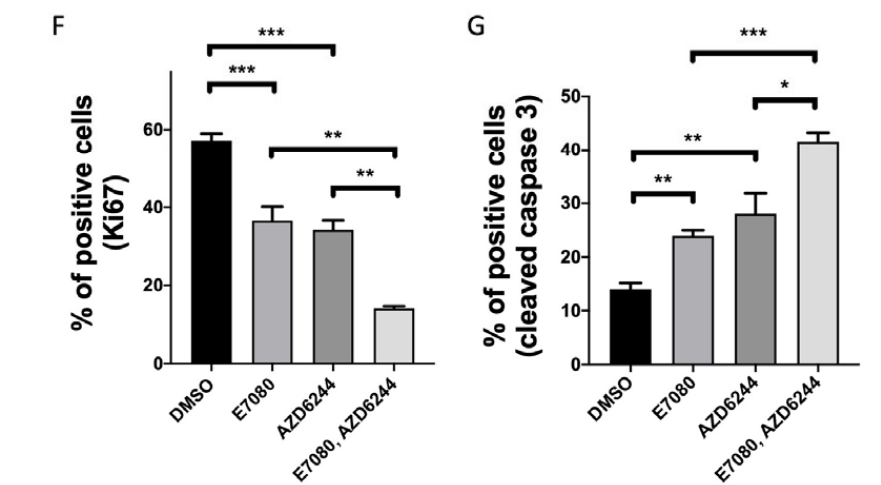
Figure 3. Antitumor effects of lenvatinib and selumetinib in 8505C-inoculated athymic BALB/c nude mice. An equal number of 8505C cells (1 × 10 6 cells) was injected into the flanks of each mouse before treatment. When tumors started to develop (average tumor size reached 100 mm 3 ), lenvatinib plus selumetinib, lenvatinib alone, selumetinib alone, or the vehicle was orally administered to the mice for 14 days (30 mg/kg/d). ( A ) Tumor volume, ( B ) tumor growth rate, ( C ) tumor size, and ( D ) tumor weight were decreased by treatments. ( E ) Representative images of H&E-stained tumor sections (panels a – d ) are shown. There were no marked morphological differences among the tumors from mice treated with the vehicle (panel a ), with lenvatinib alone (panel b ), with selumetinib alone (panel c ), and with the combination of lenvatinib and selumetinib (panel d ). Lenvatinib monotherapy reduced Ki67 expression (panel f ) and increased cleaved caspase 3 levels (panel j ). Selumetinib reduced both Ki67 and cleaved caspase 3 levels (panels g , k ). Furthermore, the combination of lenvatinib with selumetinib treatment strongly reduced Ki67 expression and increased the levels of cleaved caspase 3 (panels h , l ). Quantification of Ki67 ( F ) and cleaved caspase 3-positive cells ( G ) is shown. * p < 0.05, ** p < 0.01, *** p <